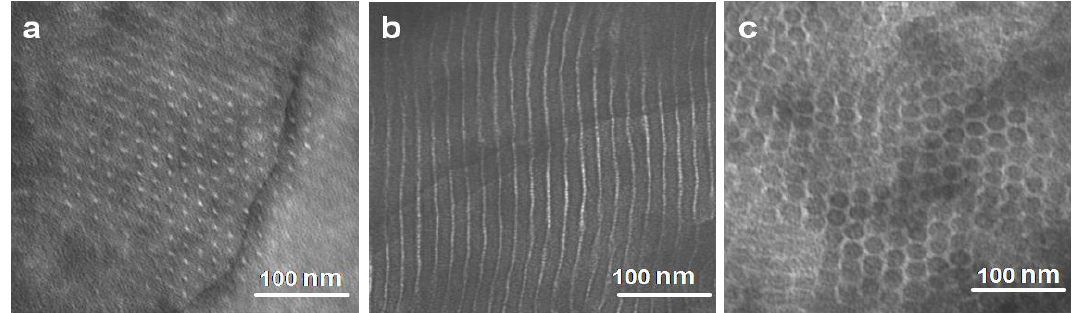
Figure 4. Transmission electron microscopy (TEM) micrographs of S- b -F block copolymers: ( a ) S74- b -F7, ( b ) S74- b -F17, and ( c ) S74- b -F42.